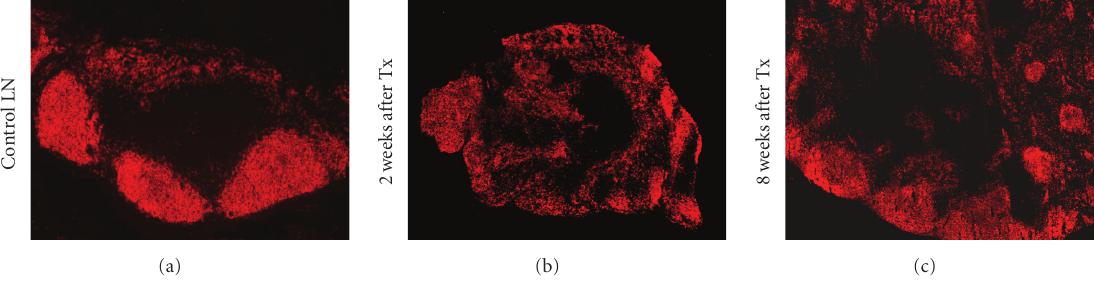
Figure 2: Early after regeneration LN are disorganized whereas after two months LN are regenerated. Cryosections of transplanted LN were stained with mAbs against B cells. The mLN of an untreated animal shows a typical compartmental structure, whereas two weeks after transplantation the architecture of the compartments is destroyed. Only small clusters of B cells are seen. Eight weeks after transplantation large B cell areas are again found, comparable to the control